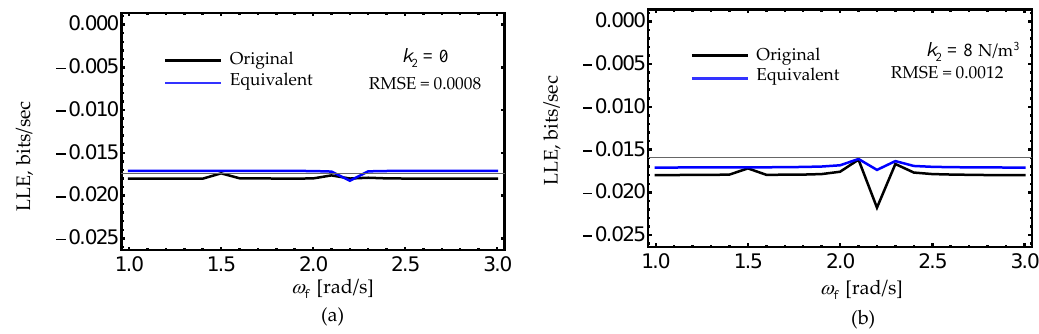
Figure 11. LLE curves computed from the numerical integration solutions of Equations (29) and (43). The parameter values used to obtain these plots were 𝑚 1 = 10 kg, 𝑚 2 = 0.8 kg, 𝑐 1 = 0.1 Ns/m, 𝑐 2 = 0.08 Ns/m, 𝑘 1 = 44 N/m, 𝑘 3 = 2 N/m, 𝑘 4 = −0.65 N/m 3 , 𝑓 0 = 0.37 N, and (a) 𝑘 2 = 0 and (b) 𝑘 2 = 8 N/m 3 . Here, the black line represents the LLE computed from the numerical integration solutions of Equation (43), while the blue line describes the LLE obtained from Equation (29).